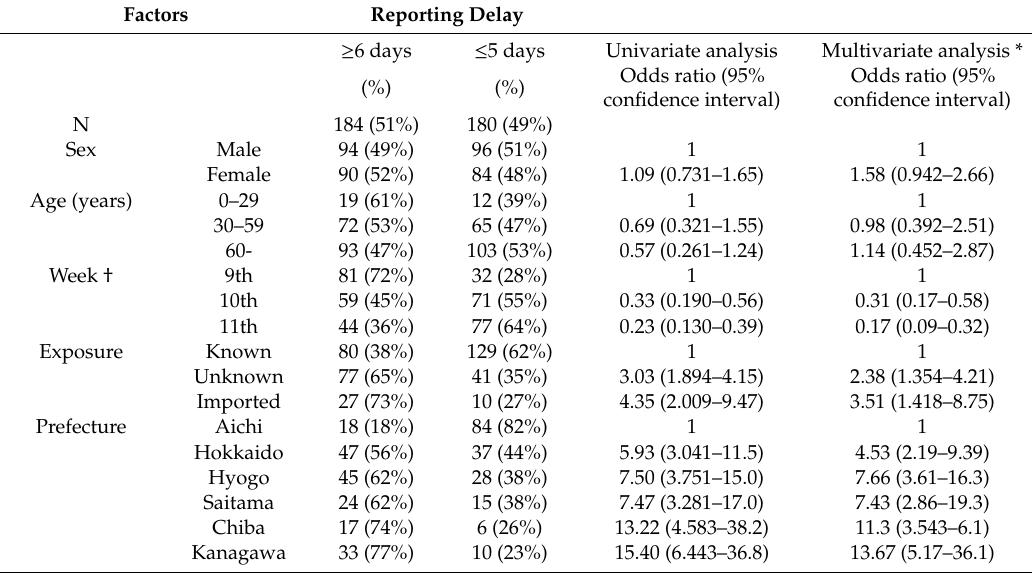
Table 2. Factors associated with long diagnostic delay ( ≥ 6 days) in the symptomatic COVID-19 cases observed between 9th and 11th week, 2020, in